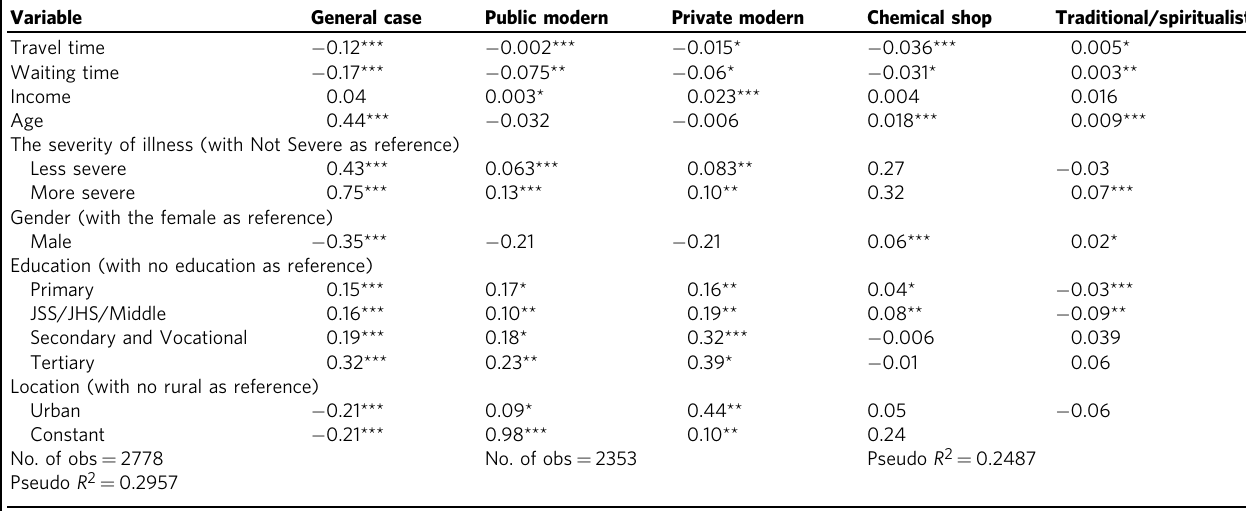
Table 3 Effect of time price on a choice of type of healthcare providers: no care as the reference group.